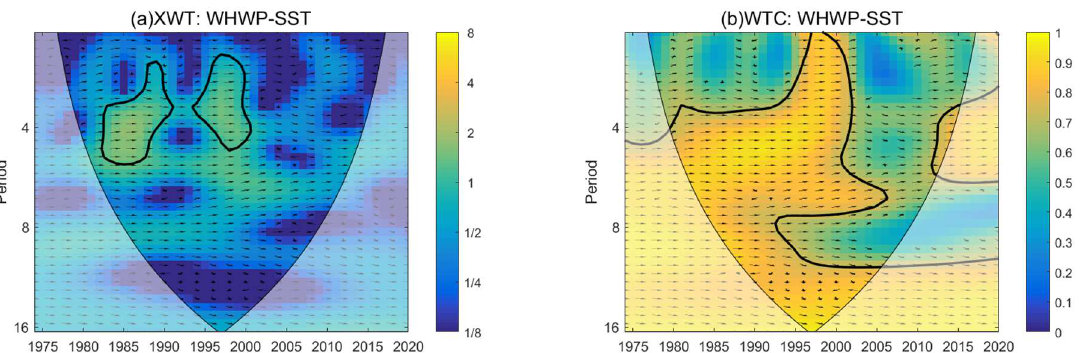
Figure 16. XWT of WHWP and SST in the tropical western Indian Ocean. ( a ) energy spectrum; ( b ) condensation spectrum.